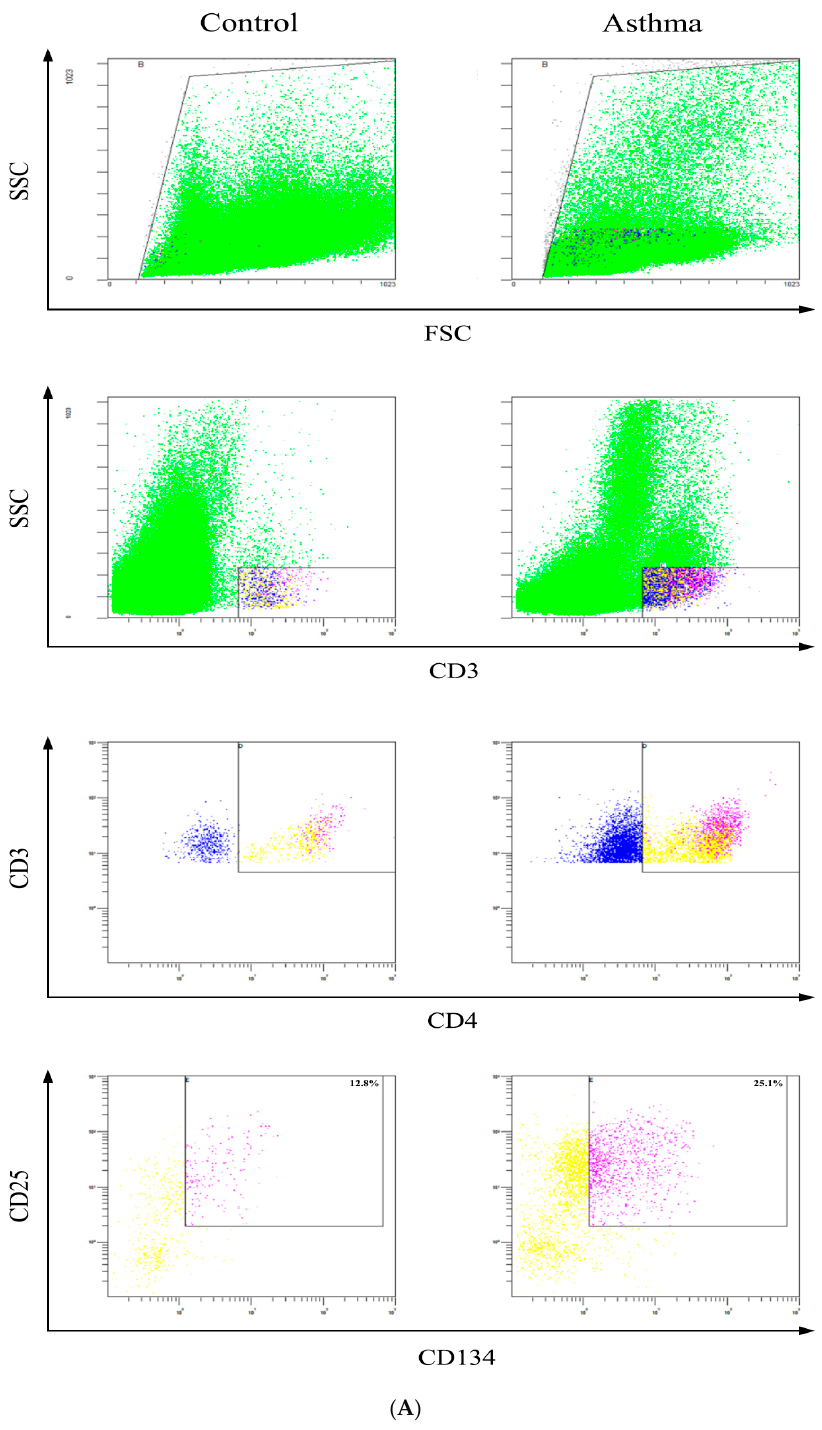
Figure 5 . Cont. Figure 5.